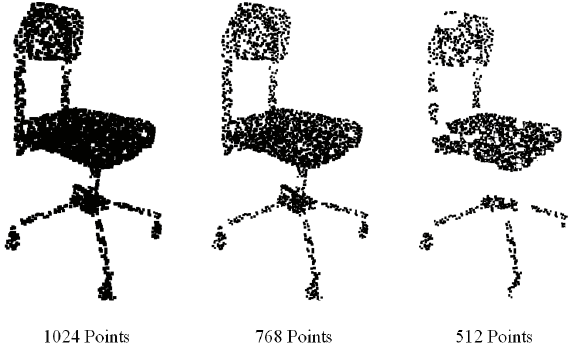
Figure 5. Effect on accuracy with reduced point clouds.